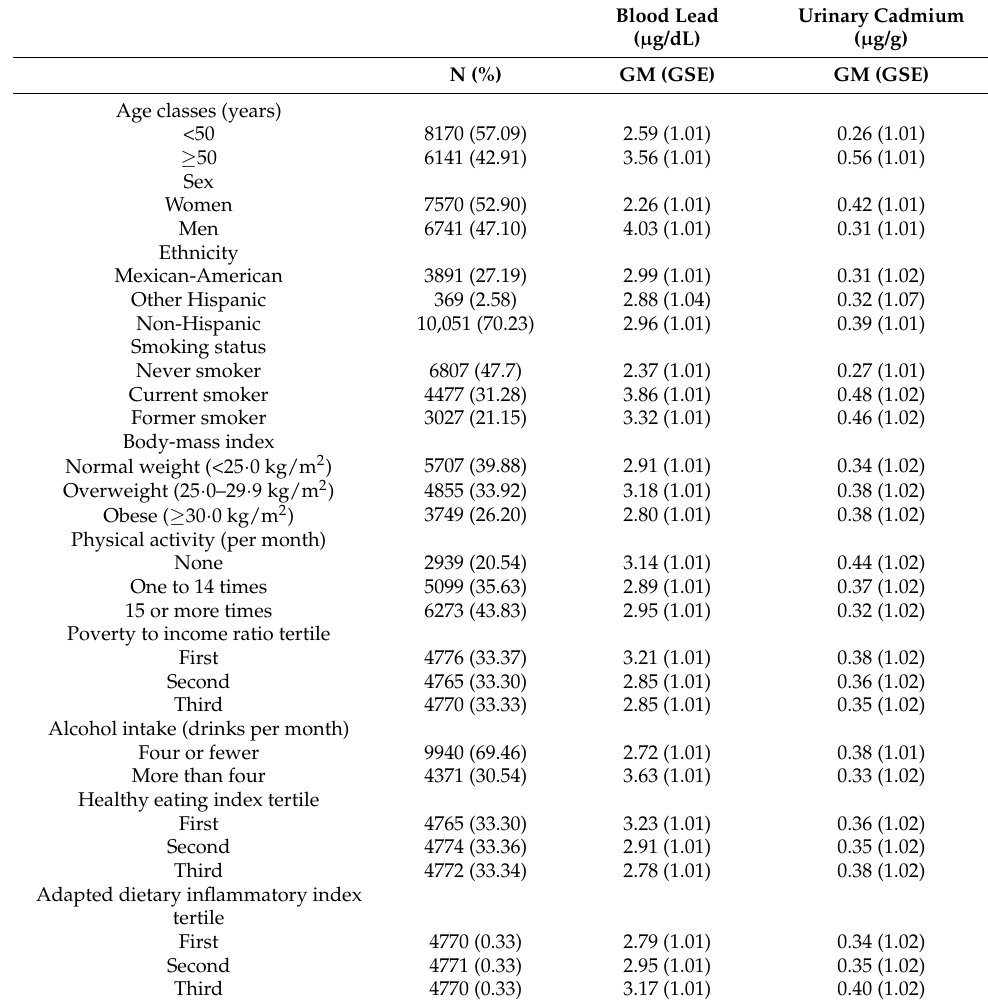
Table 1. Geometric means and standard errors of blood lead and urinary cadmium levels by study population baseline